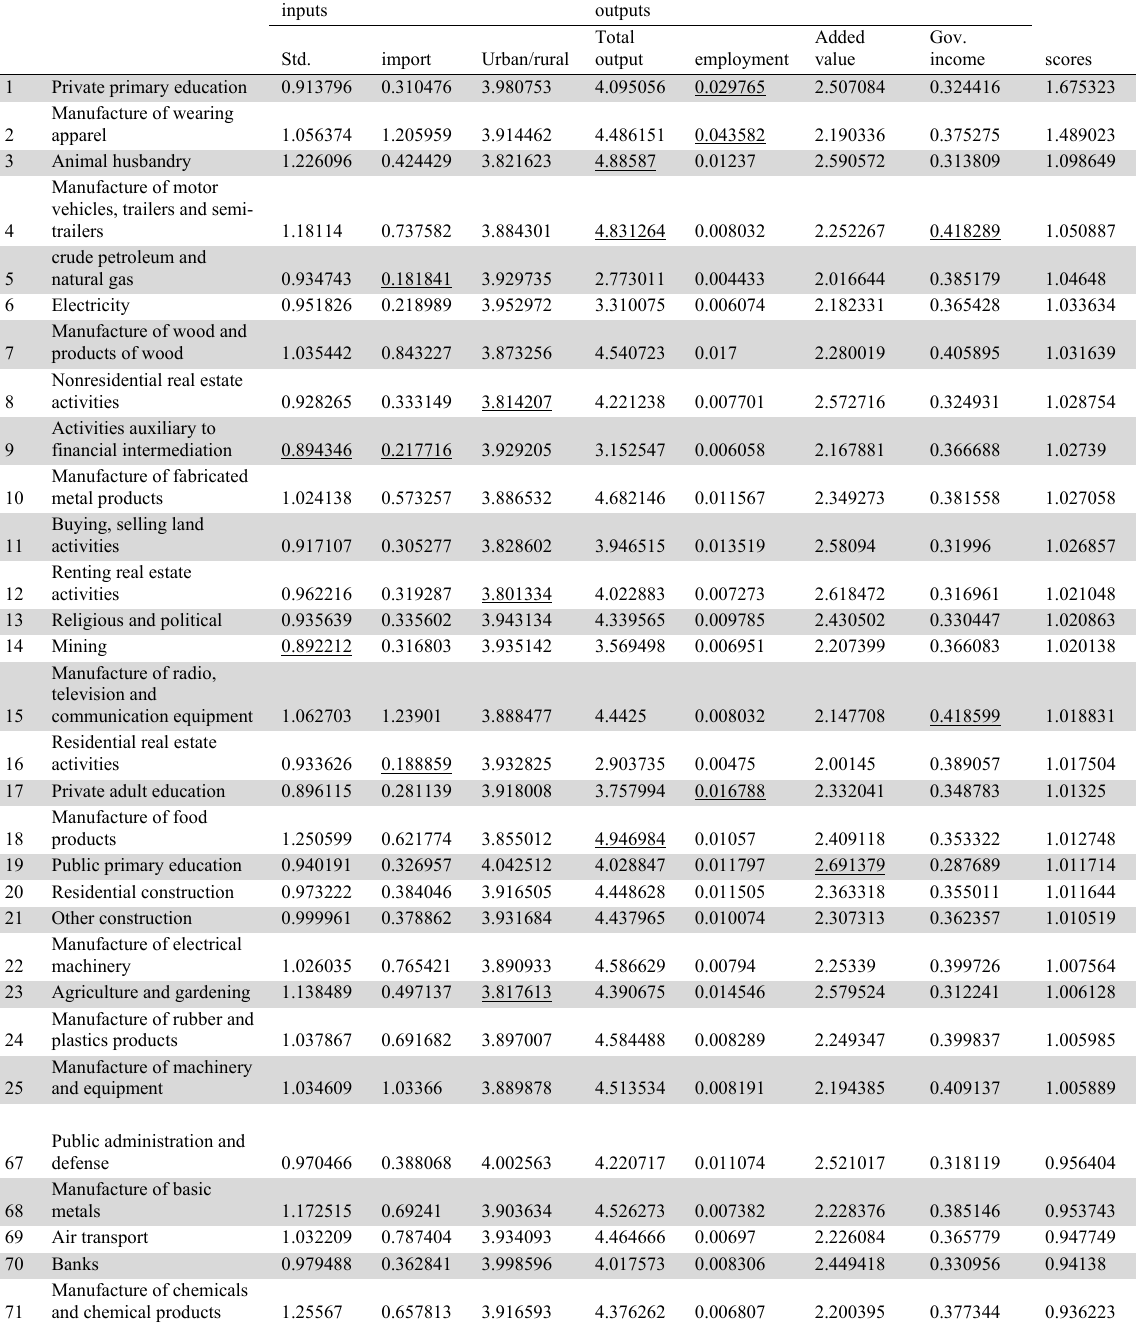
SAM multipliers and super efficiency scores for economic